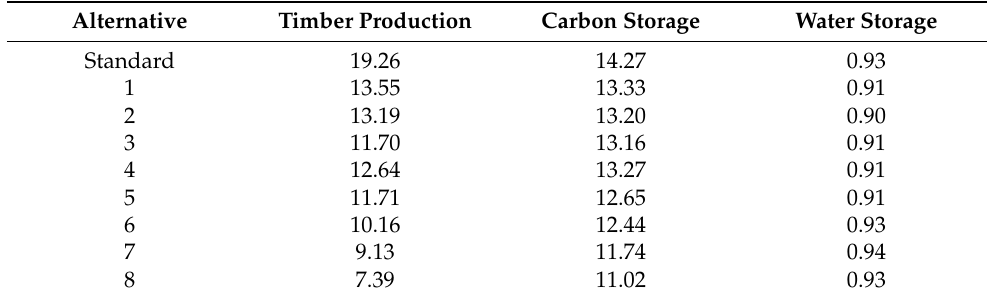
Table 8. Average variation rate (%) of the volume of each objective (timber production, carbon storage, and water storage) by periods in alternatives.